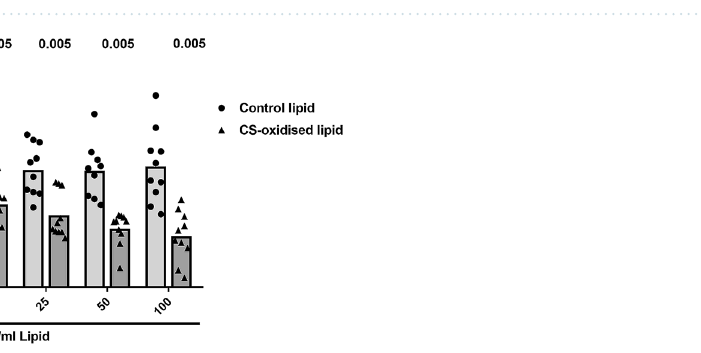
Figure 6. Oxidised epithelial cell lipids increase macrophage CD1b expression and cause epithelial cell death. ( A ) MDM or ( B , C ) 16HBE were exposed to media with or without cigarette smoke extract (CSE), with varying concentrations of CS-oxidised epithelial lipid (6.25–50 µg/mL) for 24 h, and CD1b expression was measured by flow cytometry using an unconjugated primary antibody and an APC-conjugated secondary antibody. p values vs control provided from Wilcoxon Signed Rank test. n = 9–10. Data are presented as mean with individual data points. Significance from control p < 0.05. ( B ) Necrosis of 16HBE cells measured by sytox positive cells ( C ) Apoptosis of 16HBE cells measured by Annexin V positive cells. Data represents mean ± SEM. n = 6, significance from control p < 0.05, Mann Whitney U test.